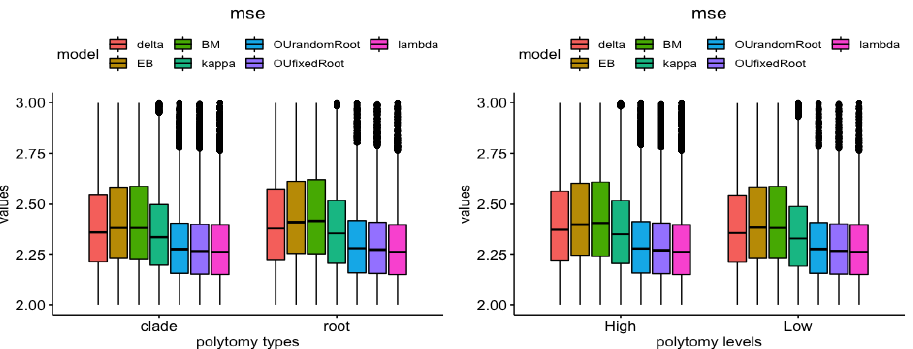
Figure 20. MSE concerning different models and polytomy types. Left panel : polynomial type vs. models. Right panel : polynomial level vs.